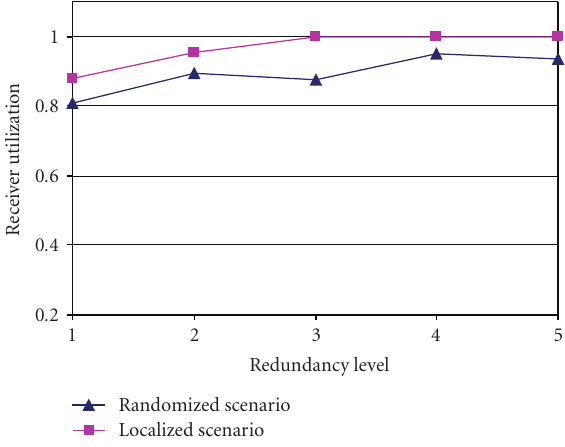
Figure 3: Receiver Usage—Moderately Loaded. Figure 4: Receiver Usage—Heavily